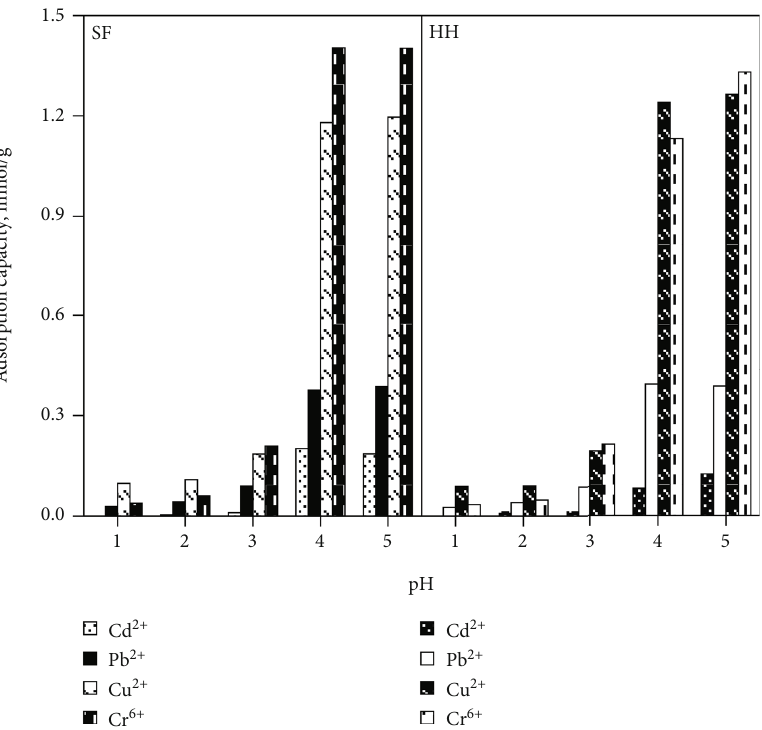
Figure 3: Adsorption of heavy metal ions on SF and HH at 298 K and pH1 – 5.